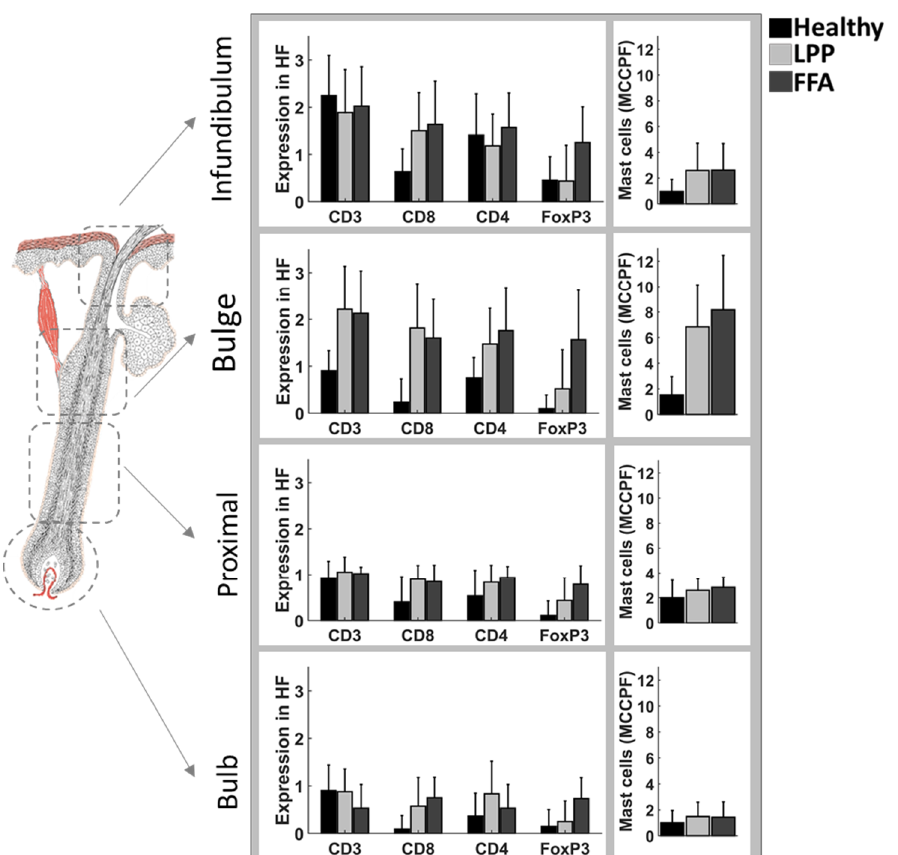
Figure 7. Semiquantitative analysis of CD3+, CD4+, CD8+, FoxP3+ cells and mast cells. Semi-quantitative analysis of antibodies against CD3+, CD4+, CD8+, FoxP3+ cells and mast cells (Giemsa staining), in the different follicular compartments of interest and their corresponding perifollicular mesenchymal compartments, representing the connective tissue sheath around each follicular compartment; infundibulum, bulge region, proximal area, and bulb. For mast cells, the y -axis shows the mean number of mast cells per follicular and perifollicular compartment. For CD3+, CD4+, CD8+ and FoxP3+ expression was scored as follows: 0, no expression; 1, mean cell count per field (MCCPF) between 1 and 10; 2, MCCPF between 10 and 20; or 3, MCCPF more than 20. H ( n = 3), LPP ( n = 11), FFA ( n = 8). LPP, lichen planopilaris; FFA, frontal fibrosing alopecia.